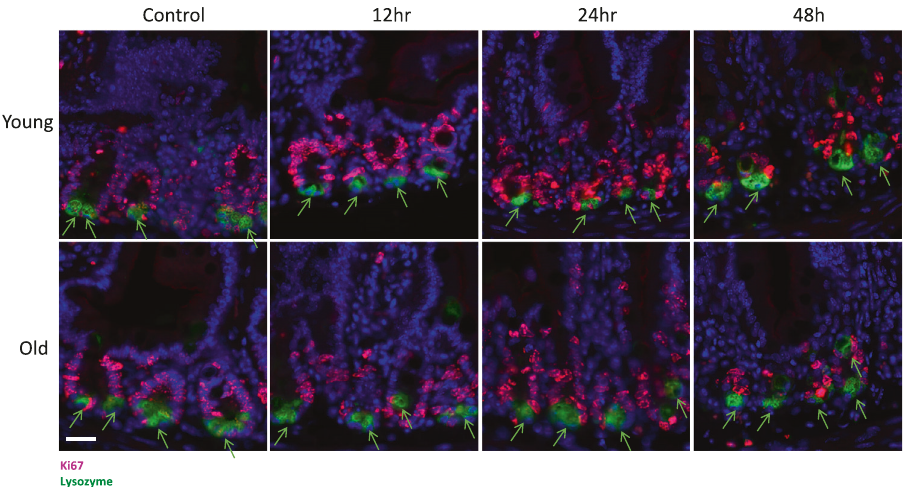
Fig. 6 The sections of proximal jejunum were obtained from young adult and old mice sacri fi ced at 12, 24, and 48 h post 14 Gy irradiation. Paneth cell proliferation was assessed by IHF double staining of nuclear protein Ki67 (red) and Paneth cell marker lysozyme (green). Green arrows indicate lysozyme staining. Representative images containing 4 to 6 Paneth cells were shown. Scale bar 20